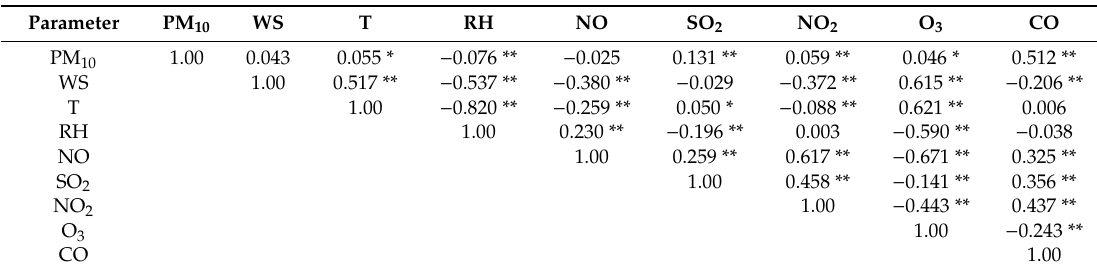
Table 3. Spearman correlation of PM 10 between meteorological factors and other gaseous pollutants during periodic haze events.